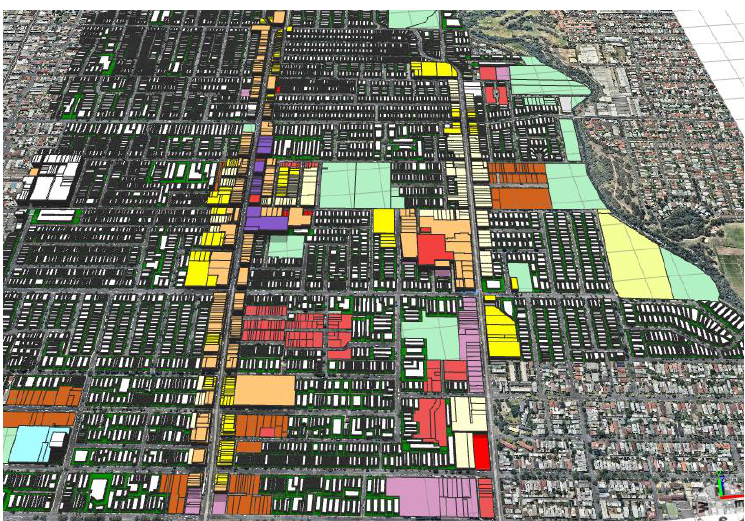
Figure 7. 3D model of the Nicholson Street and Lygon Street development controls as per the planning scheme controls in Figure 5.